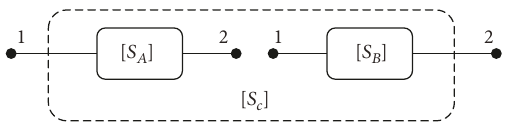
Figure 4: Representative picture of two cascaded